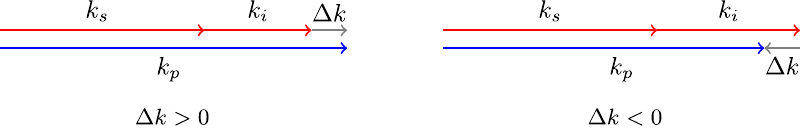
Figure 1. The momentum-difference vector can be both positive and negative, thus requiring a positive or negative QPM order m